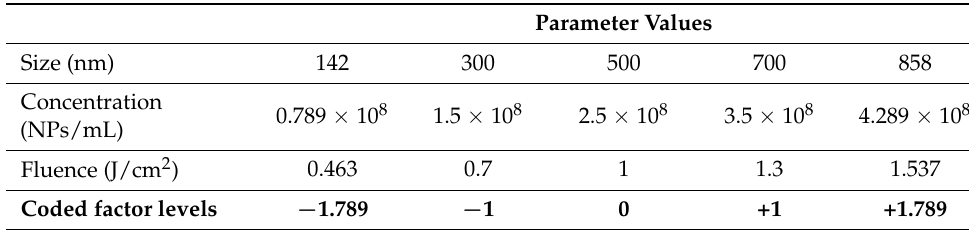
Table 5. Overview of the parameter values included in the design and their translation to coded values (bold) as they are used in the RSM